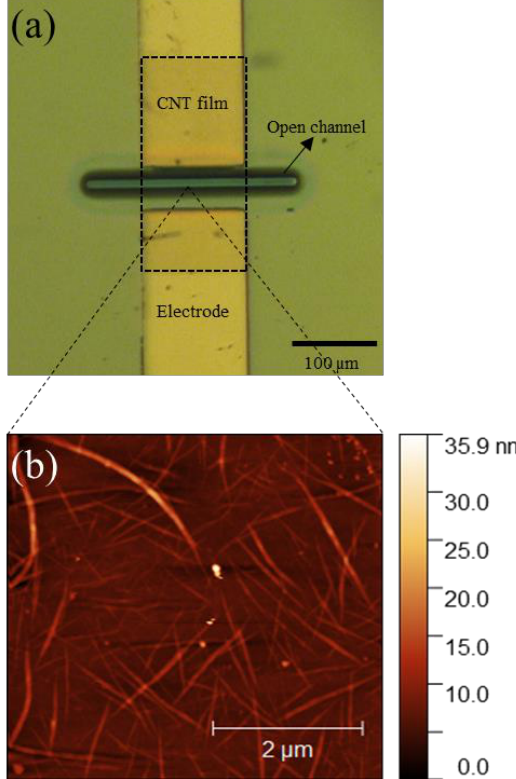
Figure 2. ( a ) Microscopic image of the CNT channel with encapsulated source and drain electrodes in a completed FET device and ( b ) AFM image of the CNT film deposited on the SiO 2 /Si substrate which consist of large bundles with a diameter of ~20 nm and single